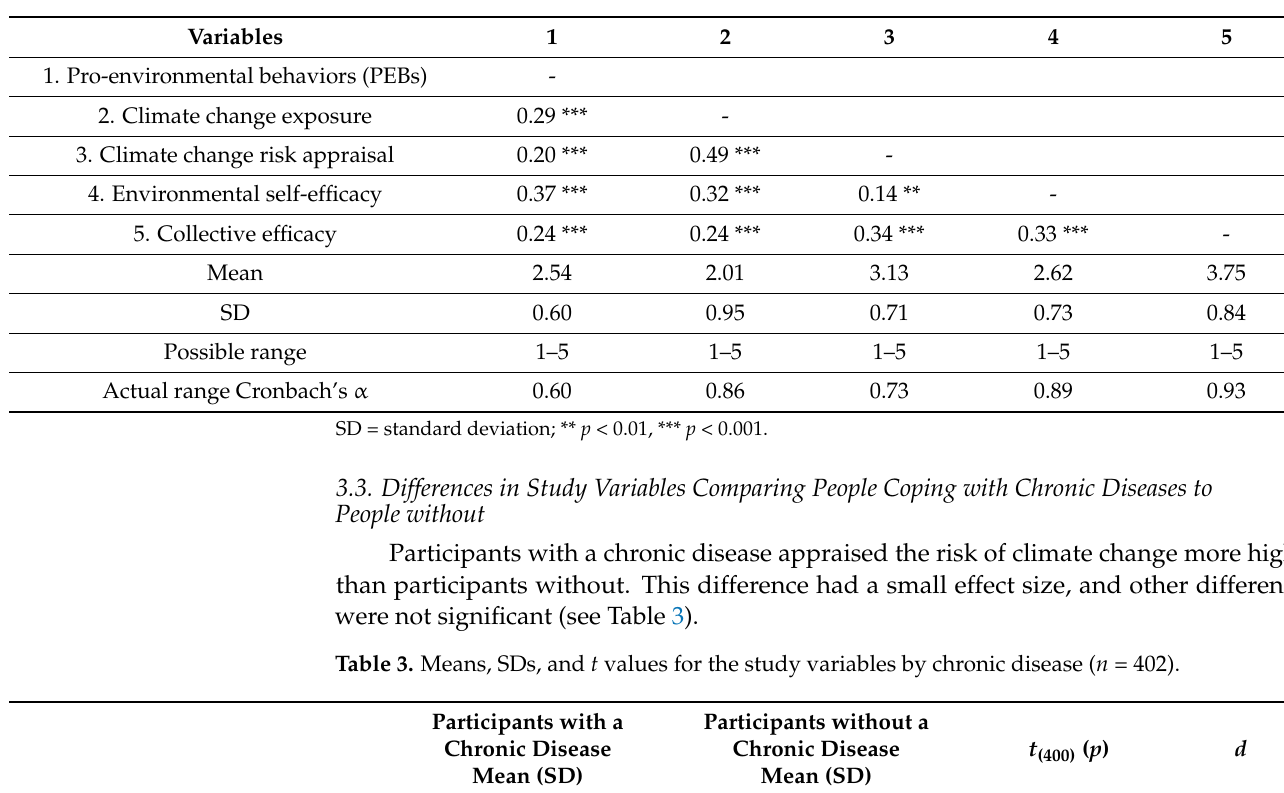
Table 2. Means, SDs, ranges, Cronbach’s α , and correlations for the study variables ( n = 402).